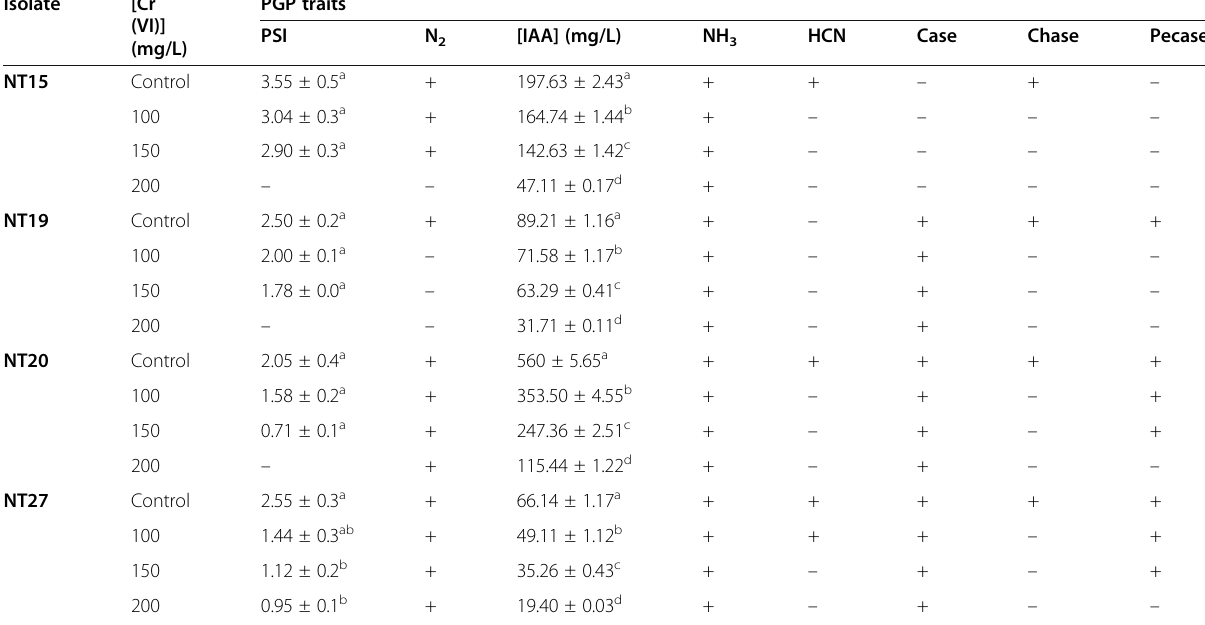
Table 2 Growth-promoting traits of the selected bacterial isolates (NT15, NT19, NT20, and NT 27) in the presence of Cr (VI) at 100, 150, and 200 mg/L. Data are the mean of replicates with SE ±. Values with different letters are significantly different ( p < 0.05)